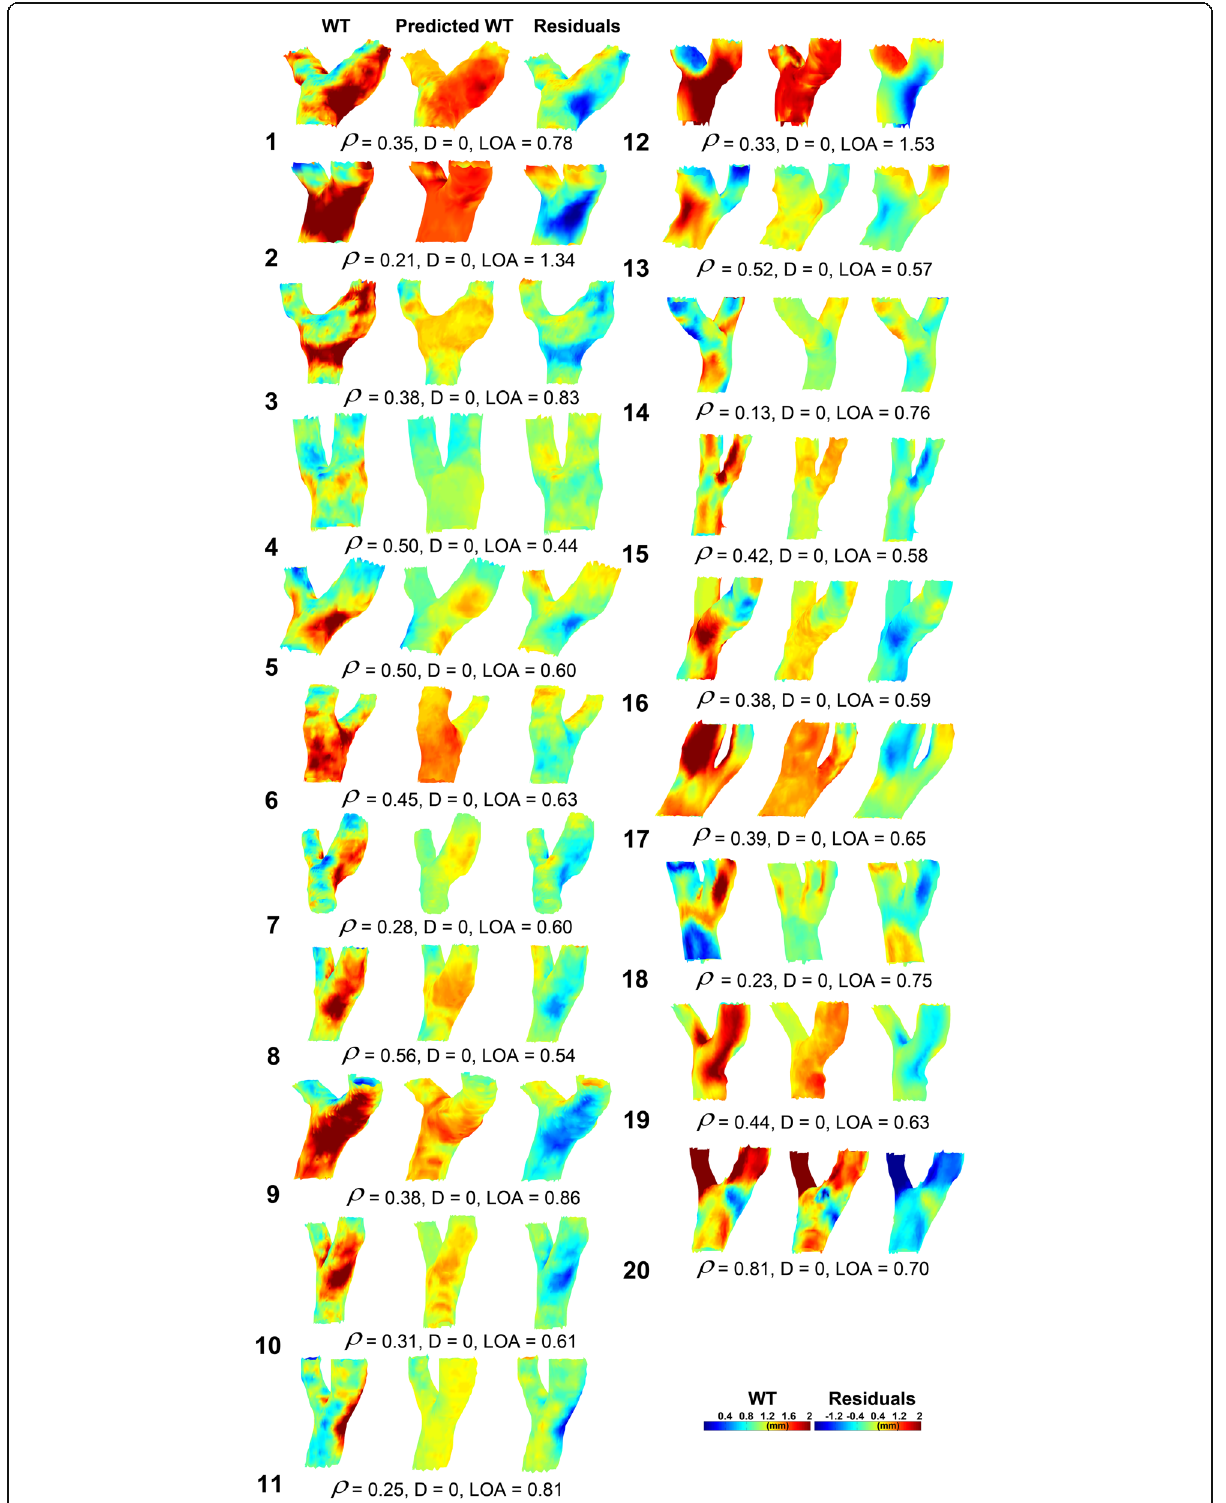
Fig. 4 The predicted WT maps ( center column ) based on linear regression of the individual WT, WSS and diameter maps compared to the original WT maps ( left column ). The right column shows the 3D residual maps. Spearman ’ s ρ is given. D and LOA represent the difference and limits of agreement from the Bland-Altman